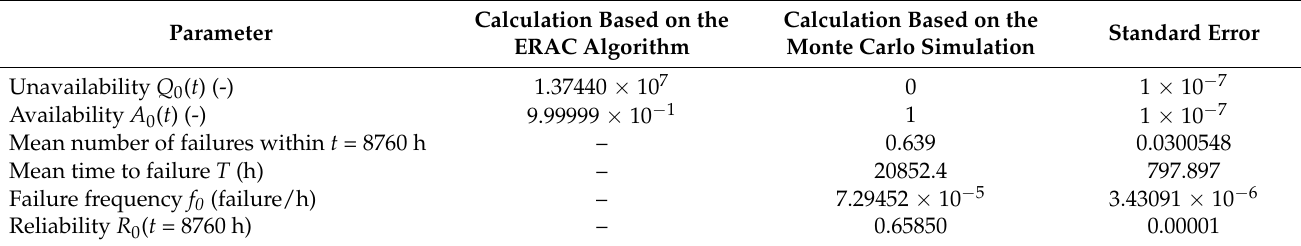
Table 3. Reliability measures calculated for the top event of the analyzed